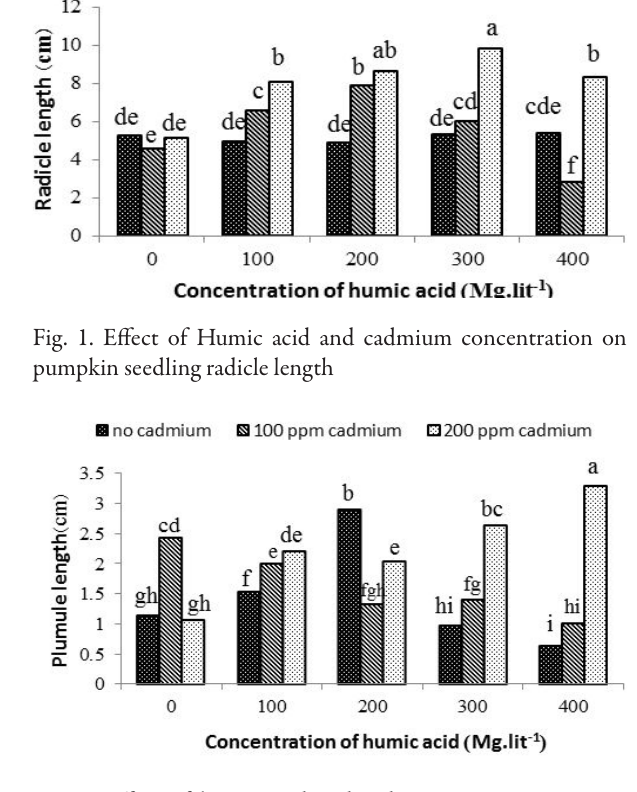
Fig. 2. Effect of humic acid and cadmium concentration on pumpkin seedling plumule length